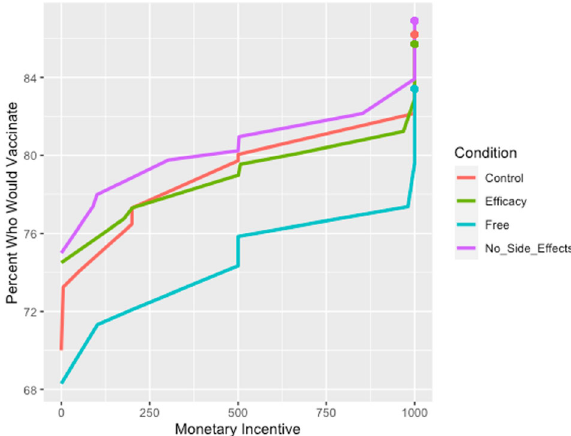
Fig. 6 Percent accepting vaccination as a function of the informational condition and the monetary incentive.